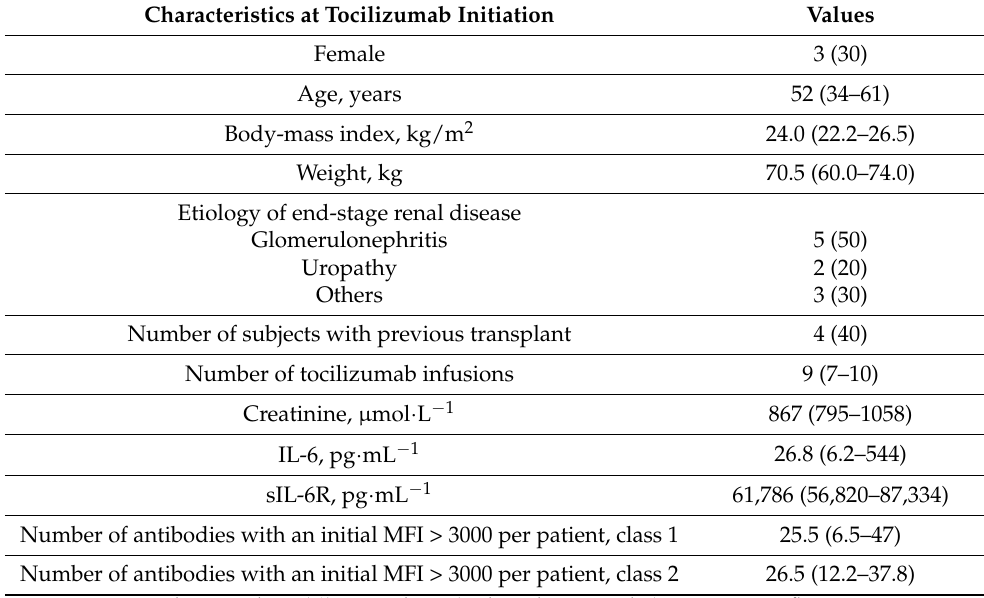
Table 1. Baseline characteristics of patients.